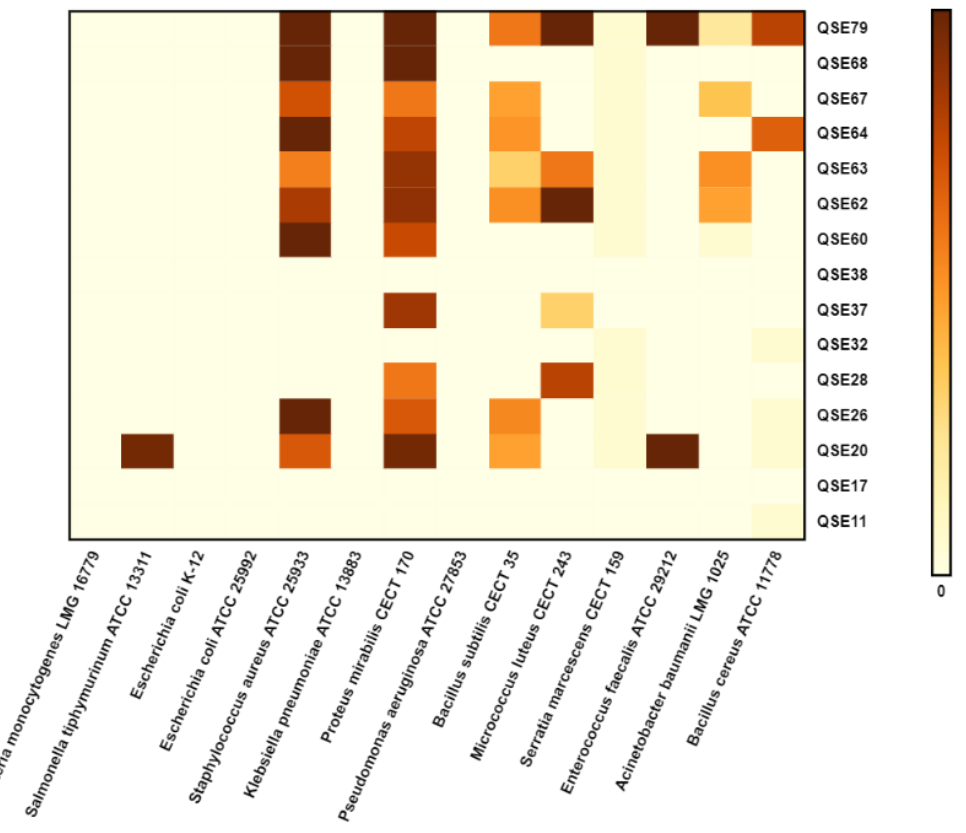
Figure 3. Inhibition activity of each selected strain against different food-borne bacterial pathogens. Units are in centimeters of radius from the margin of the cavity.